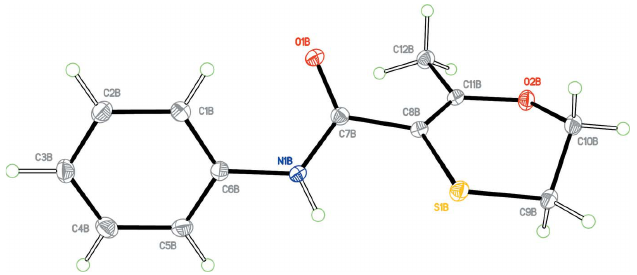
Table 2. Calculated least-squares planes through the phenyl